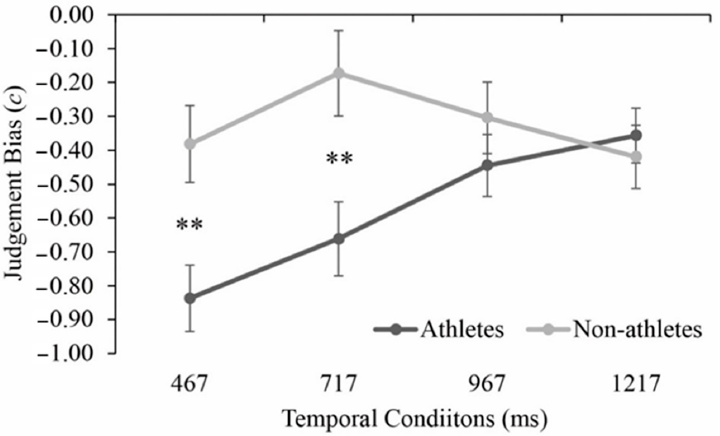
Figure 5. Mean judgement bias (c) scores for athletes and non-athletes under four temporal conditions. Bars indicate standard errors. ∗∗ p < 0.01.